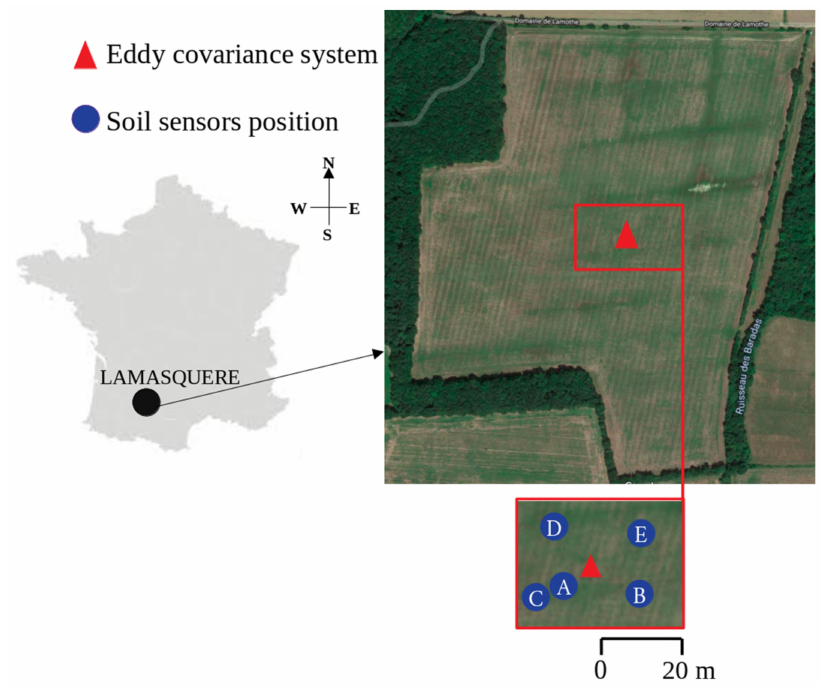
Figure 1. Map ( left ) of the geographical location of the study site in the southwest of France, and a snap shot of the experimental setup ( right ) in Lamasqu è re ( top ), and set up location ( bottom ) of the eddy covariance system. The blue circles represent the location of the pits holding the temperature, the heat flux plates, and the soil water